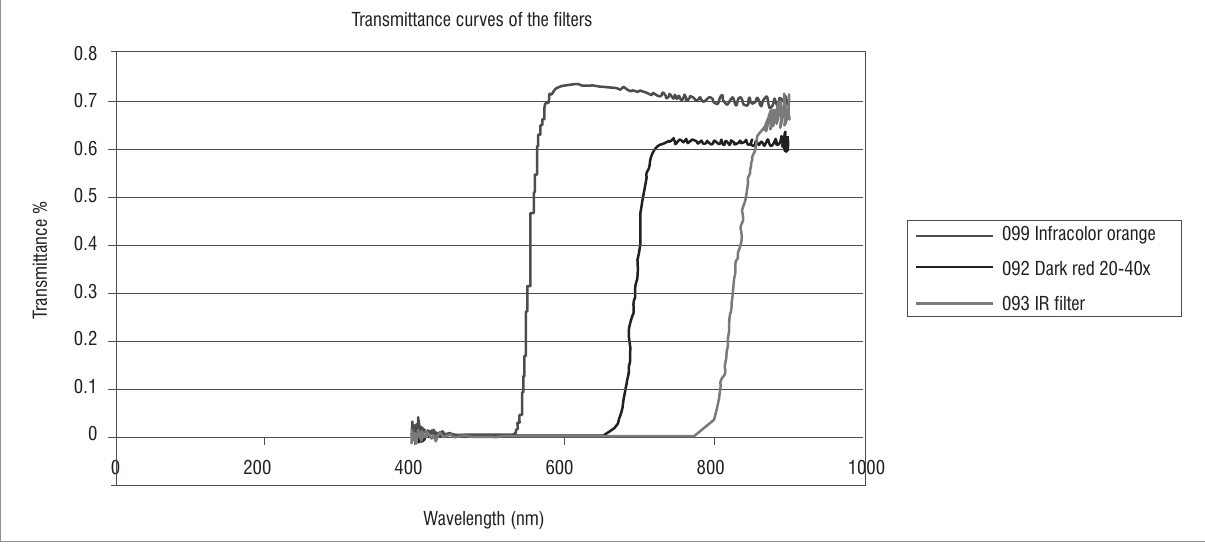
Figure 1: Transmittance curves of the B+W 099, 093 and 092